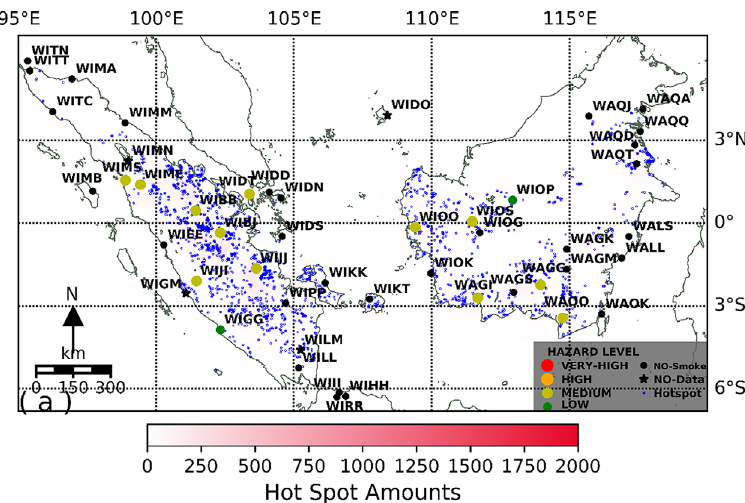
Fig. 4 a. Visibility Severity Index (VSI) July 2015. Blue dot: hotspot; hotspot density showed in a red colour heat map.